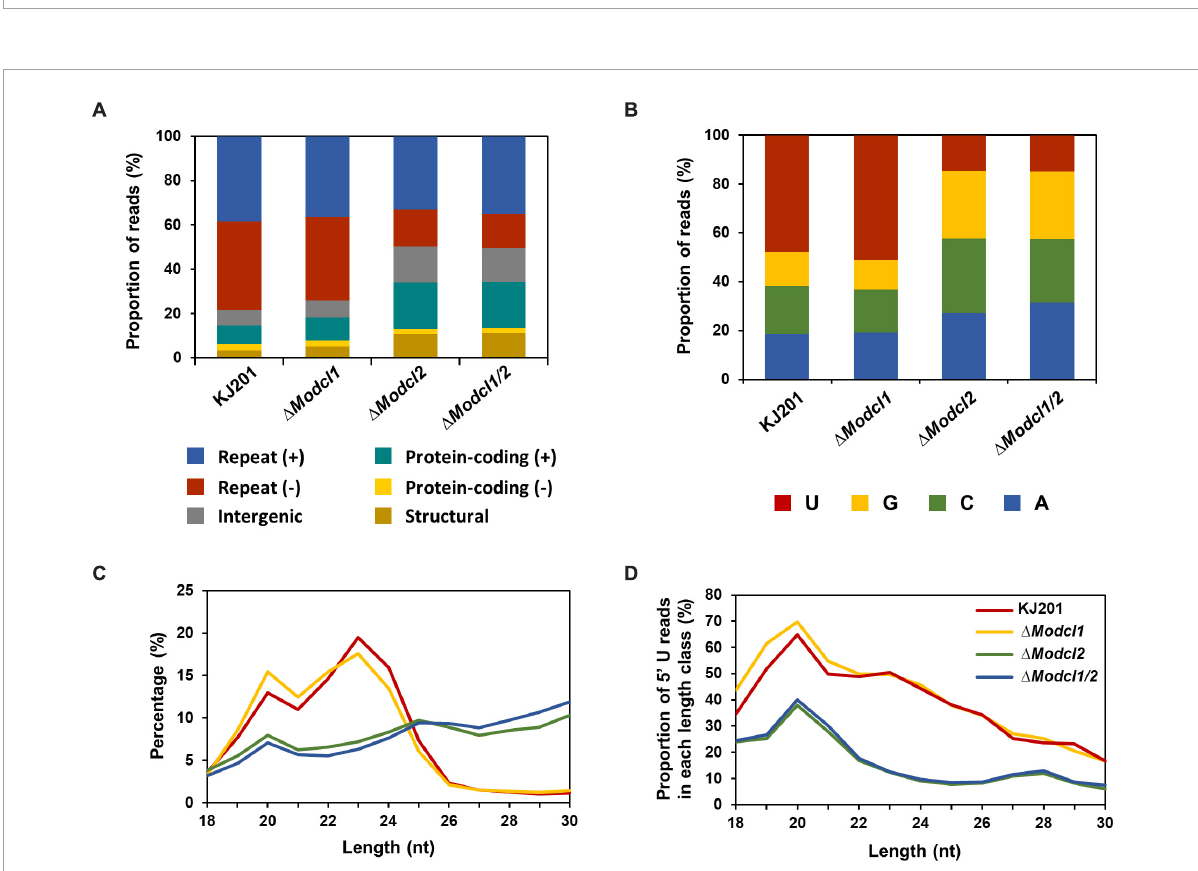
FIGURE2 Characteristics of M. oryzae sRNAs. (A) Genomic origins of sRNAs. (+) and (–), sense strand and antisense strands, respectively. (B) Nucleotide composition at the 5 (cid:48) -ends of sRNAs. (C) Length distribution of sRNAs. (D) Proportions of 5 (cid:48) -uracil reads in each length